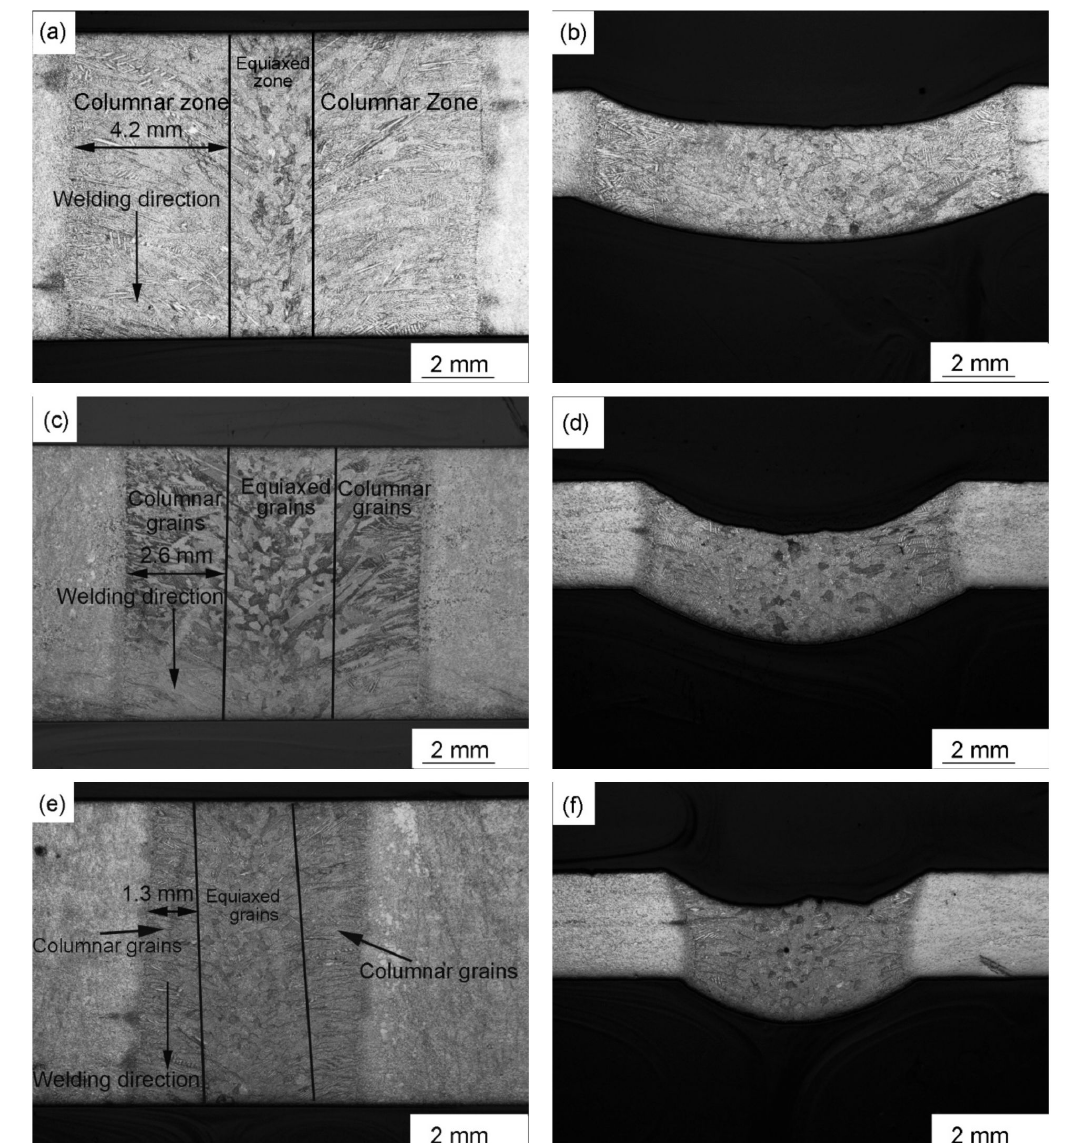
Figure 2. The macrostructures of the as-welded fusion zone for AZ31 GTA welds made using different welding speeds. ( a ) 3 mm/s (top surface). ( b ) 3 mm/s (weld cross-section). ( c ) 4 mm/s (top surface). ( d ) 4 mm/s (weld cross-section). ( e ) 5 mm/s (top surface). ( f ) 5 mm/s (weld